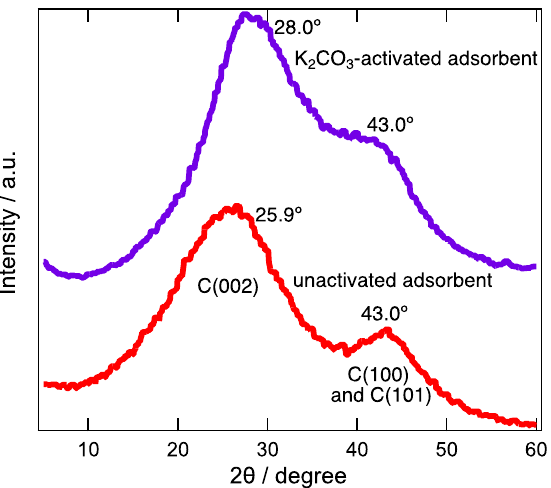
Figure 3. Powder XRD patterns of unactivated adsorbent (red) and K 2 CO 3 -activated adsorbent (purple).